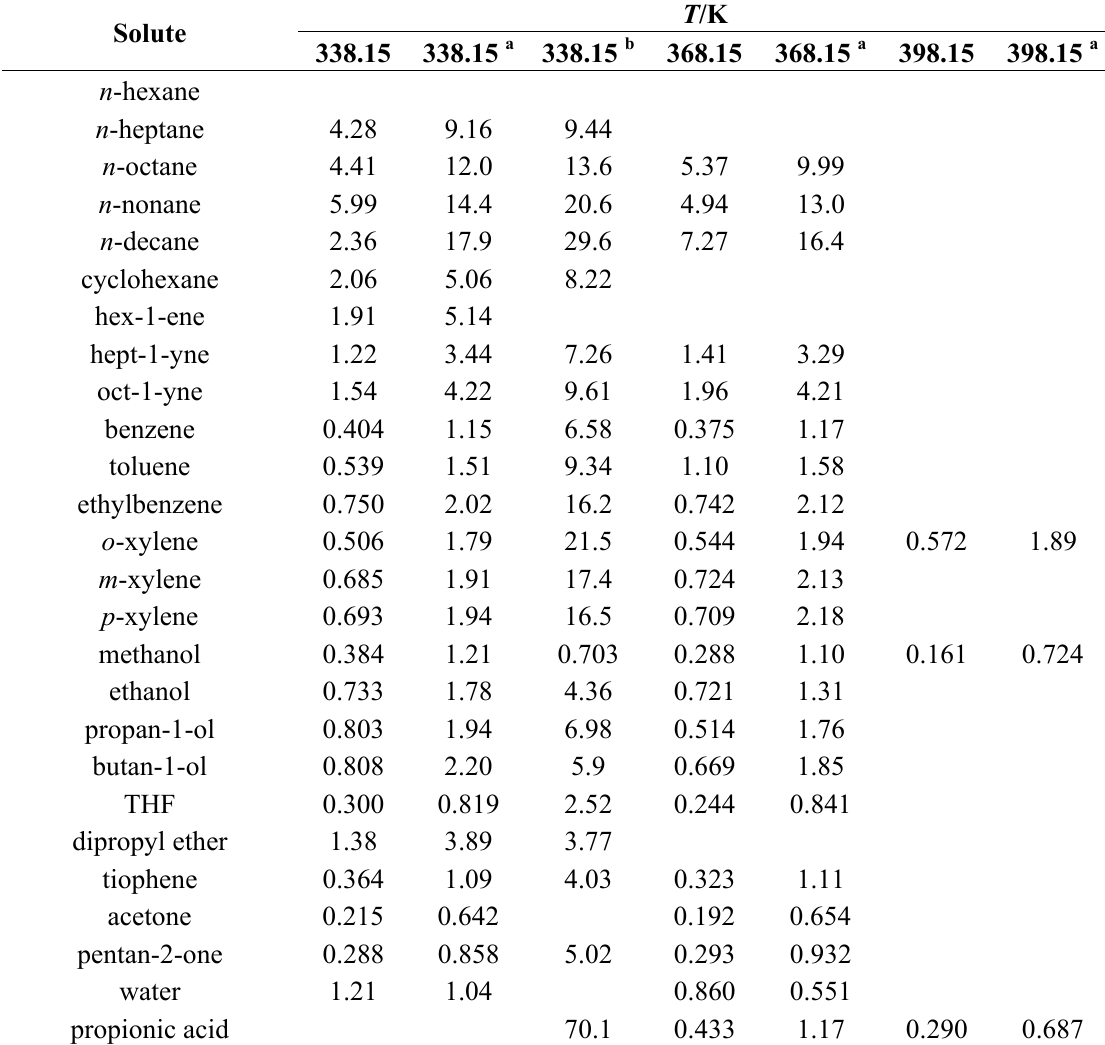
Table 4. The experimental activity coefficients at infinite dilution, ∞ IL [OMIM][NTf ] (19.82 w %), IL {[OMIM][NTf 2